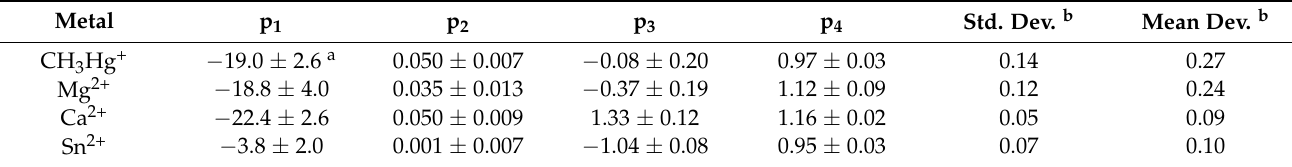
Table 14. Empirical parameters for the modeling of pL 0.5 values of the metal/dopamine systems with respect to T /K, I /mol dm − 3 and